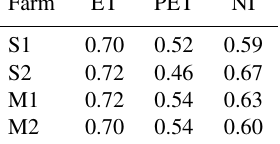
Table 4. Key dates relevant to barley planted on 1 April 2020 (from FAO guidelines; Pereira et al., 2015).